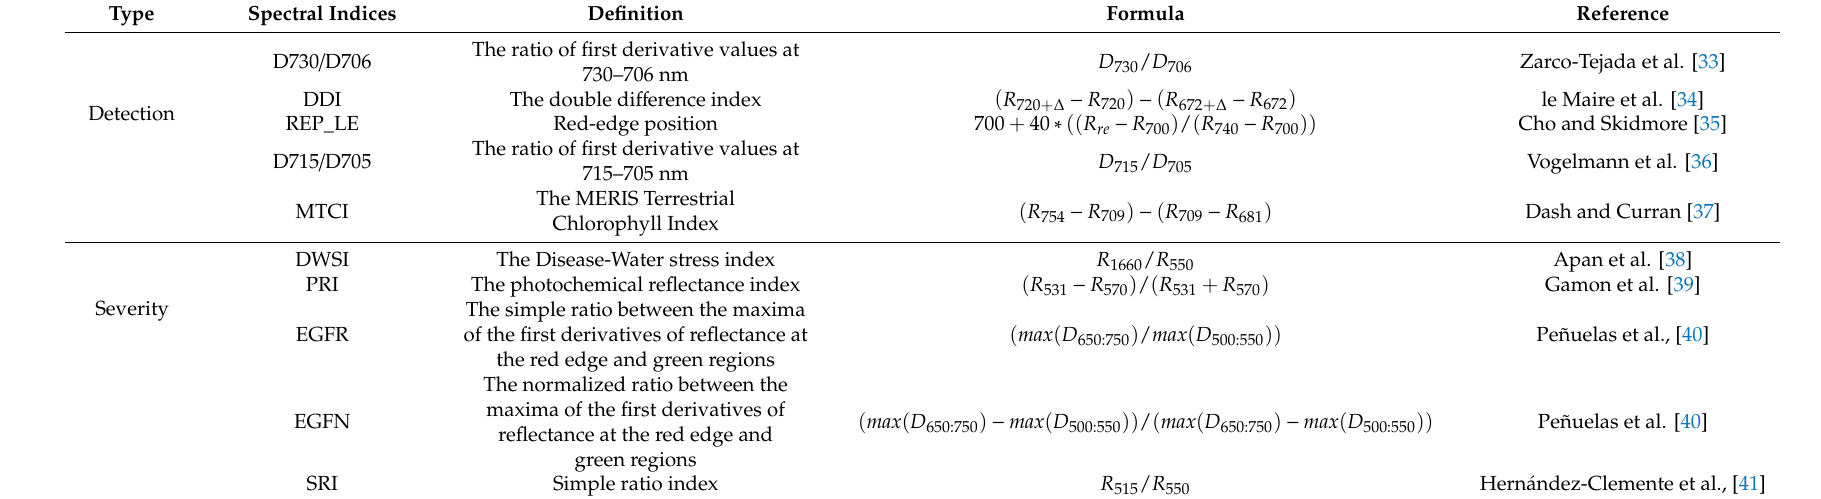
Table 2. The spectral indices used for SCR detection and severity